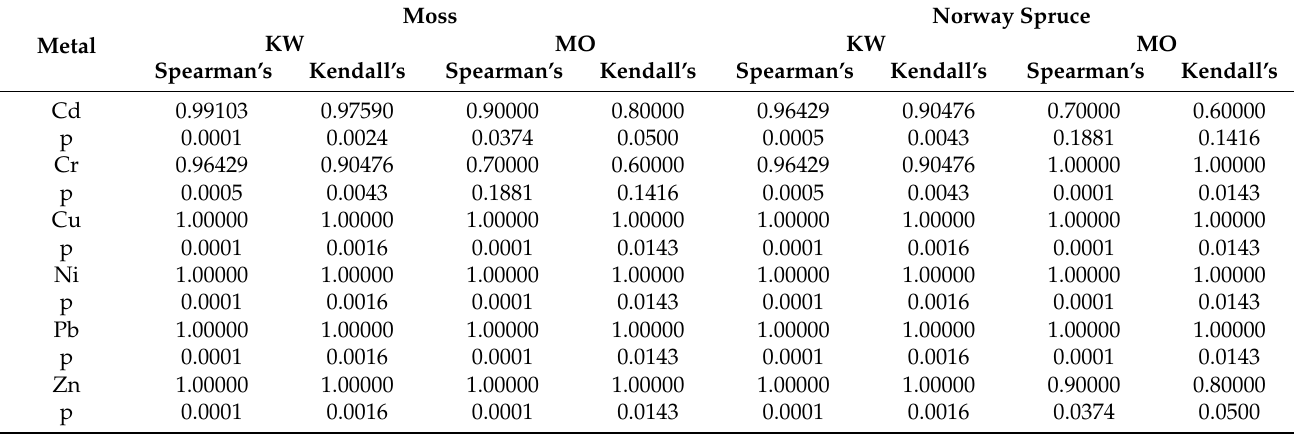
Table 5. Spearman’s and Kendall’s rank correlations without outliers for plants in the test areas (Kasprowy Wierch-KW and Morskie Oko-MO) in the Tatra National Park,